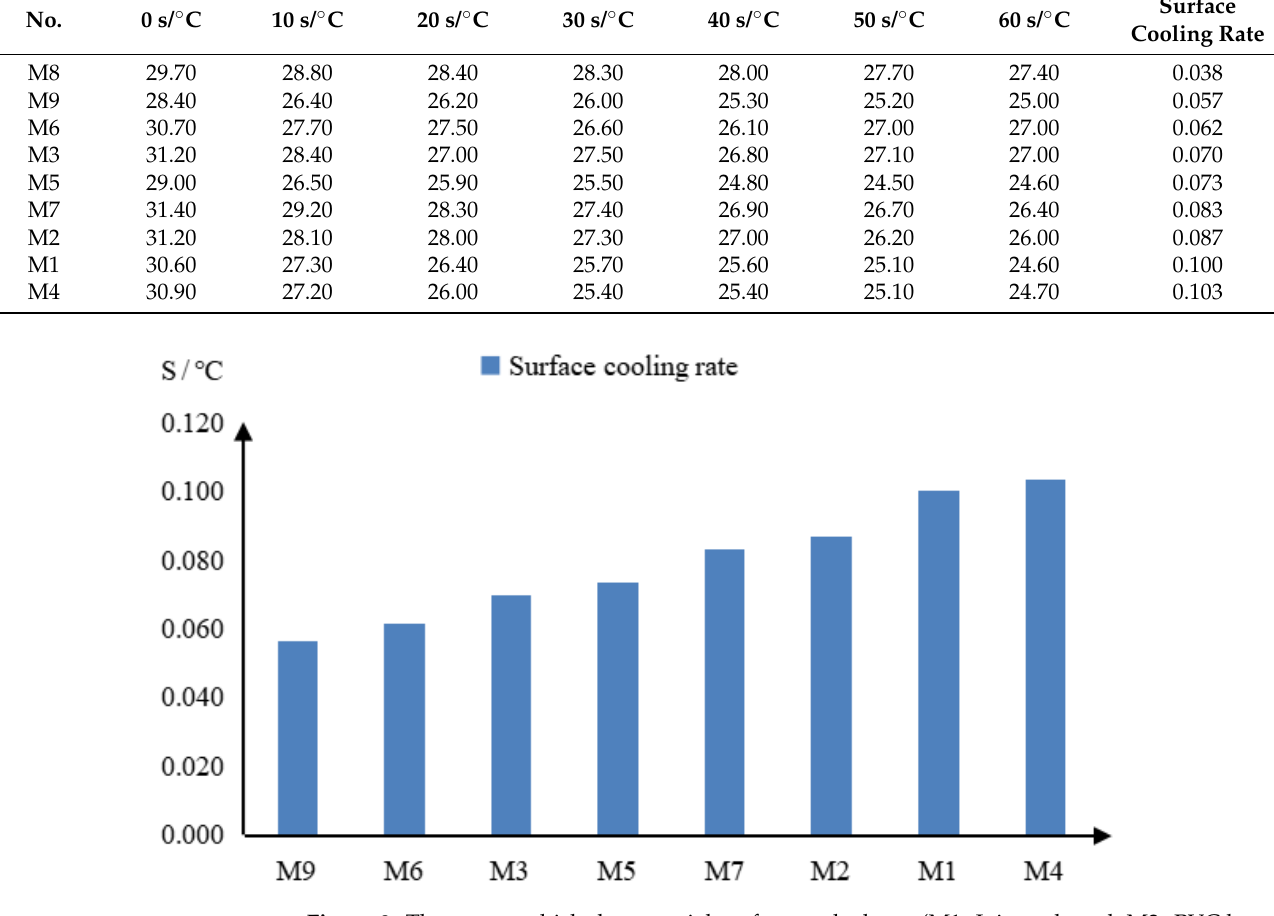
Figure 8. The rate at which the material surface cools down (M1: Joinery board, M2: PVC board, M3: Fireproof board, M4: Solid wood board, M5: Painted solid wood board, M6: Melamine board, M7: Painted board, M9: Quartz board).